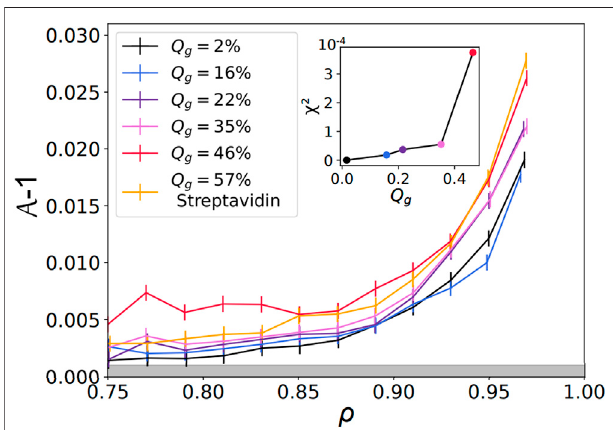
FIGURE 5 | Shape factor as a function of the packing fraction — A − 1 calculated for each droplet as a function of its local packing fraction ρ for all experimental conditions. Inset: χ 2 calculated between the curve obtained for non-adhesive emulsions (black curve) and the curves obtained for DNA droplets at various ratios. The curves are growing increasingly further away from the black curve as Q g is increased from 16 to 46 % . The grey box represents a lower bound on the values of A − 1 which we can